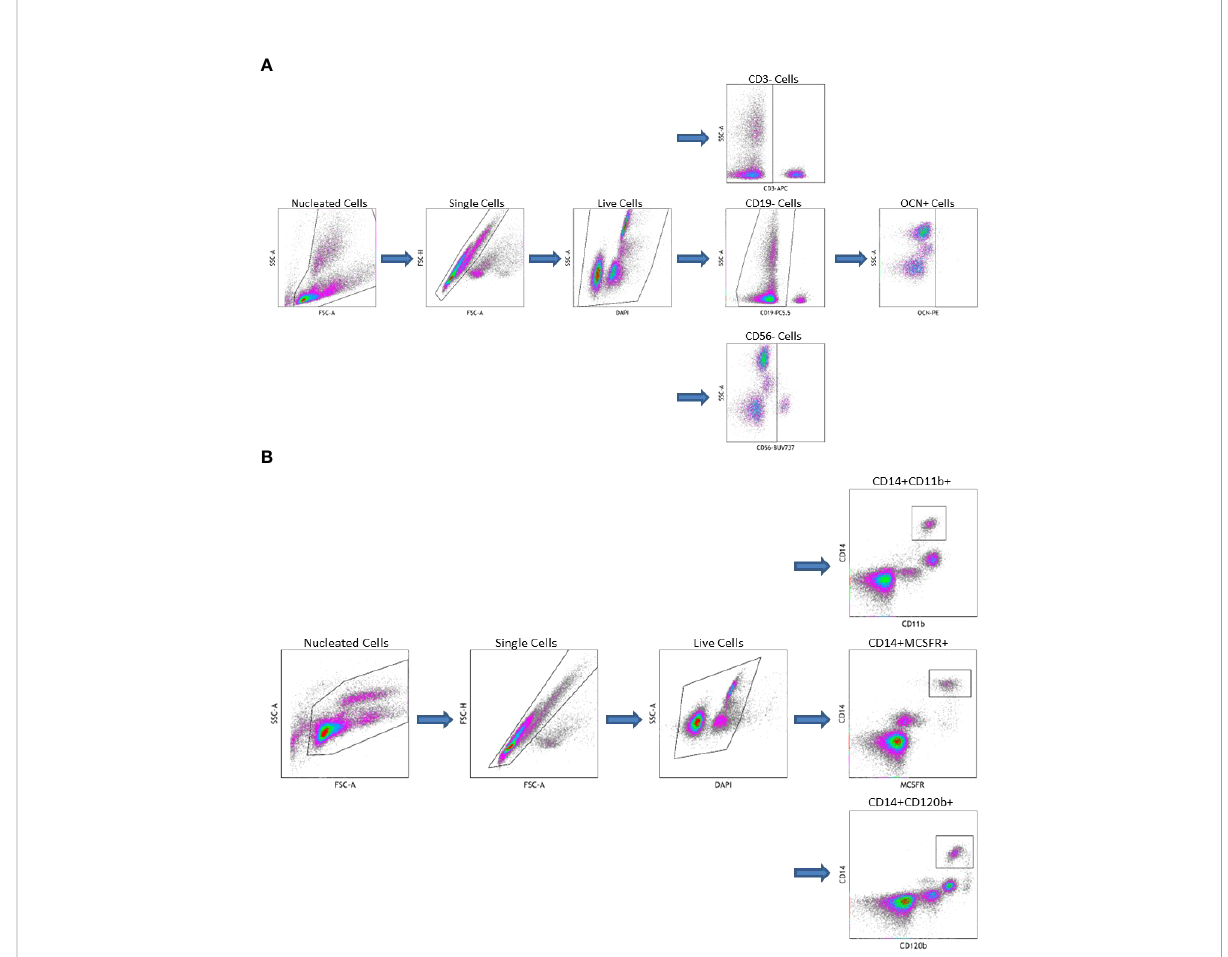
FIGURE 1 (A) Gating Strategy for Circulating Osteogenic Progenitor Cell Isolation. Cells are fi rst sorted along forward/side scatter to identufy nucleated cells, then forward area and height to identify singlets, then DAPI-negative cells are identi fi ed as viable. Cells that are CD3-CD19-CD56-are gated from this population the OCN+ cells are identi fi ed as osteoblast progenitors. (B) Gating Strategy for Osteoclast Precursor Cell Isolation. Cells are fi rst sorted along forward/side scatter to idfentify nucleated cells, then forward area and height to identify singlets, then DAPI-negative cells are identi fi ed as viable. Cells that are CD14+CD11b+, CD14+MCSFR+, or CD14+CD120b+ are identi fi ed as OC